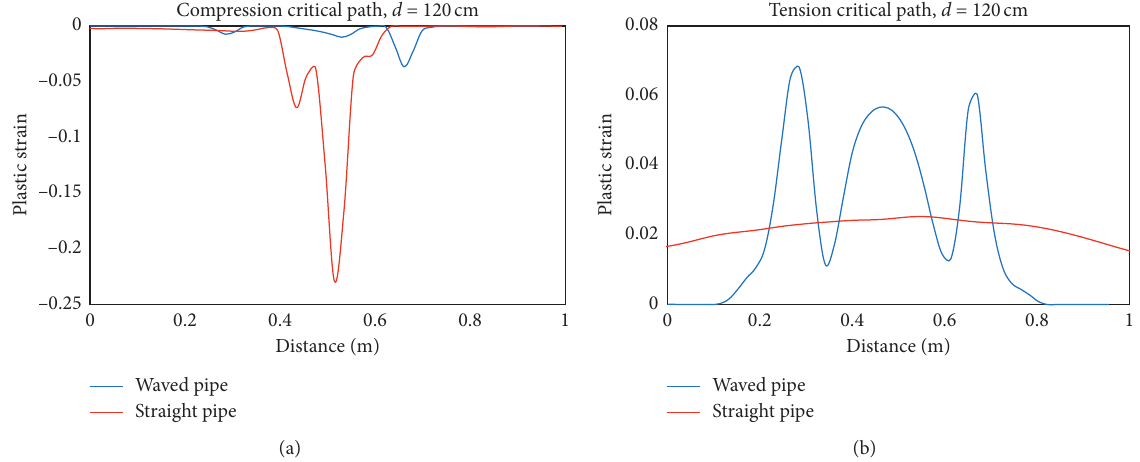
Figure 6: Comparison of plastic strain in tension and compression critical